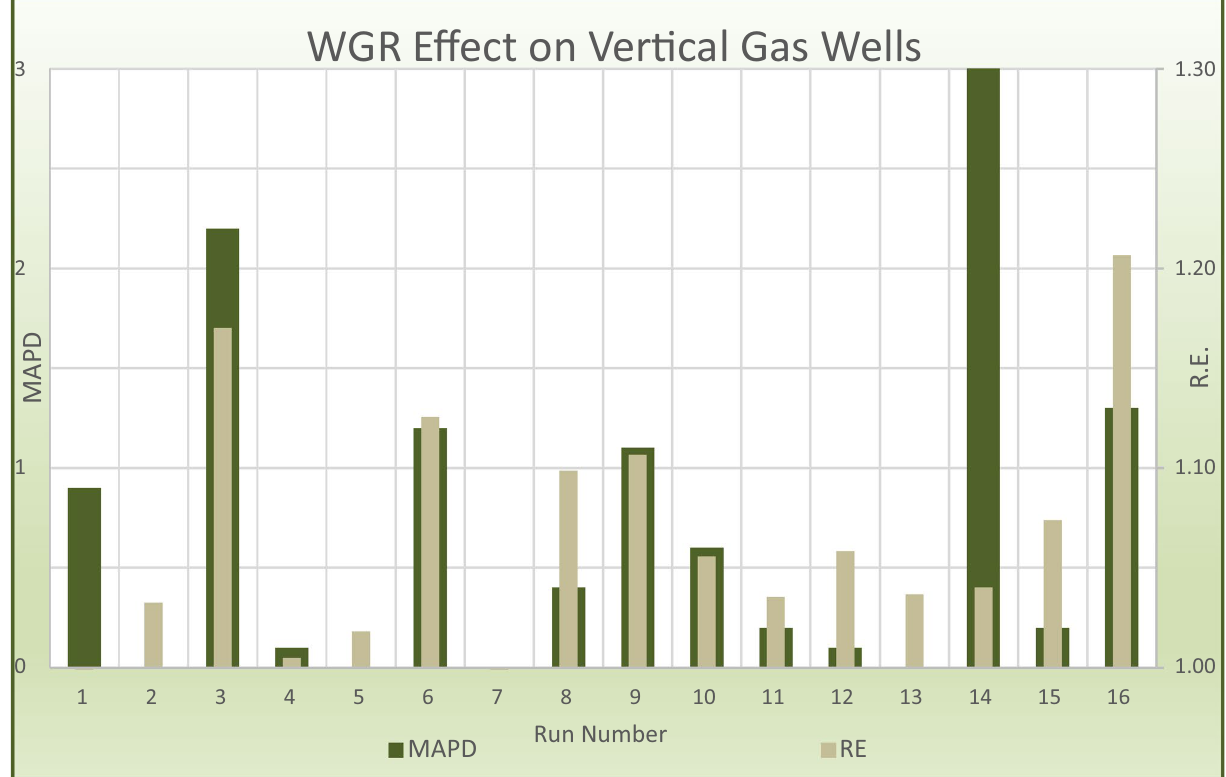
Fig. 3 Effect of WGR on vertical wells using MAPD and RE